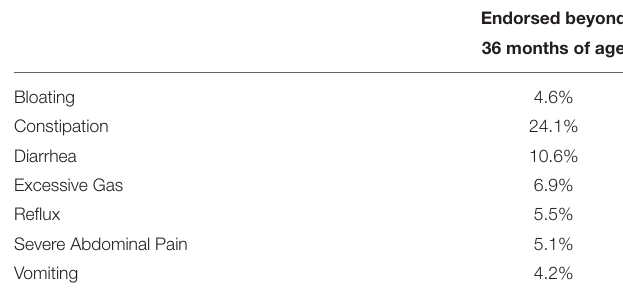
TABLE 2 | Prevalence of parent-reported GI concerns.